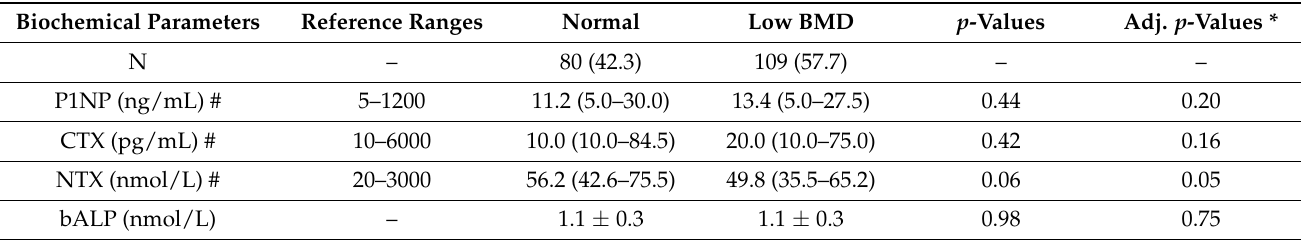
Table 3. Bone Turnover Markers of Participants according to Normal and Low BMD